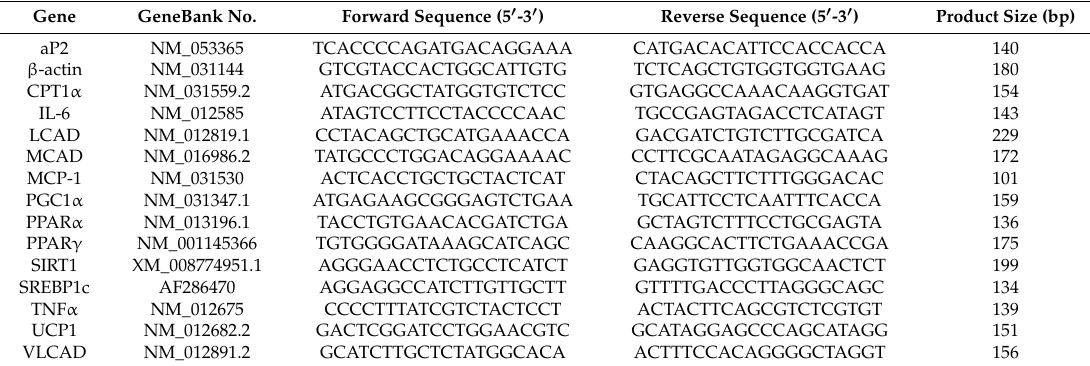
Table 2. Primers used for Real-Time Quantitative Polymerase Chain Reaction